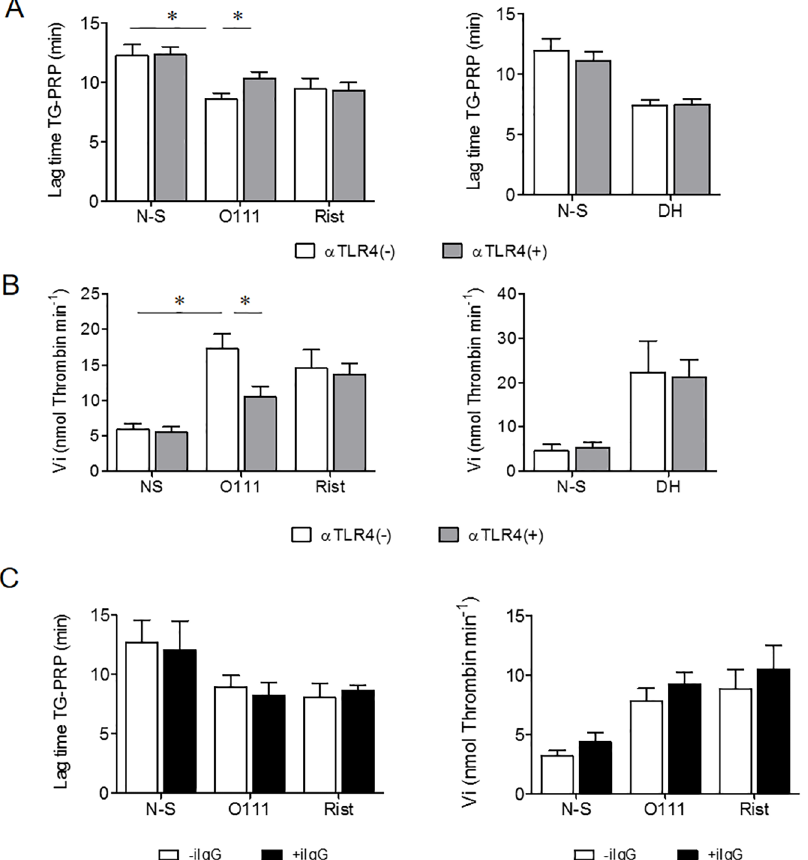
Fig 2. E . coli O111 induces platelet TF-dependent thrombin generation, involving TLR4 activation. This thrombin generationassay did not use an externalsource of TF and phospholipids, and Fc γ RIIA was previously blockedwith FcR blockingreagent. The interaction of plateletswith E . coli O111 shortened the Lag Time ( * p < 0.016, n = 7) (A) and increasedthe Velocity index of TG-PRP ( * p < 0.016, n = 7) (B) compared with N-S platelets. This effect was similar to that obtained after PRP stimulationwith ristocetin (used as positive control) or the unrelatedstrain E . coli DH5 α ,which also shortenedLag Time ( * p < 0.01, n = 3) and increasedthe Velocity index of TG-PRP ( * p < 0.03, n = 3) (right panels figures A and B). TLR4 inhibition (alongwith Fc γ R previously blocked)prolongedthe Lag Time ( * p = 0.016, n = 7) and reducedthe Velocity Index ( * p = 0.016, n = 7) of TG in PRP incubatedwith the strain O111. Nevertheless, this inhibitiondid not have effect in Lag Time nor Velocity Index when PRP was stimulatedwith ristocetin or the strain DH5 α (right panelsfigures A and B). Figure 2C shows no significantchangesin TG-PRP generatedby the strain O111 when a non-immune IgG was used (n = 4). The data was analyzedby Wilcoxon signedrank test, two-tailed.